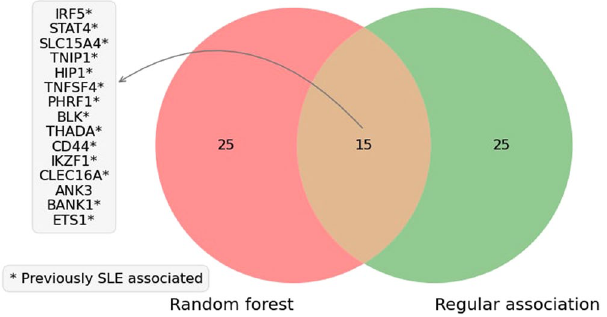
Figure 2. Overlapping genes. Genes overlapping between the top 40 genes defined by the random forest prediction and the regular single SNP association analysis.